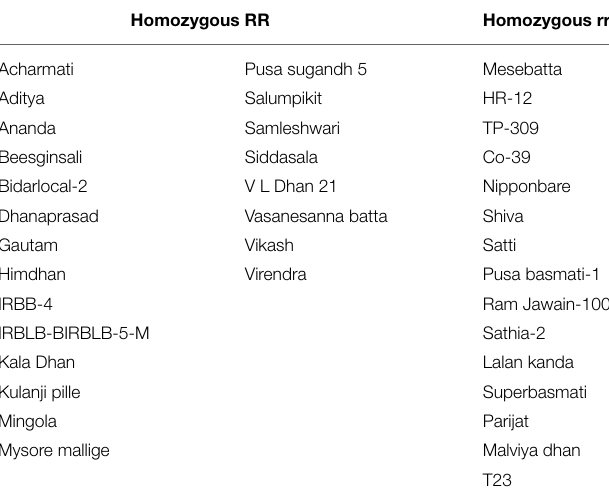
TABLE 4 | List of rice accessions distinguishable based on dominant marker.